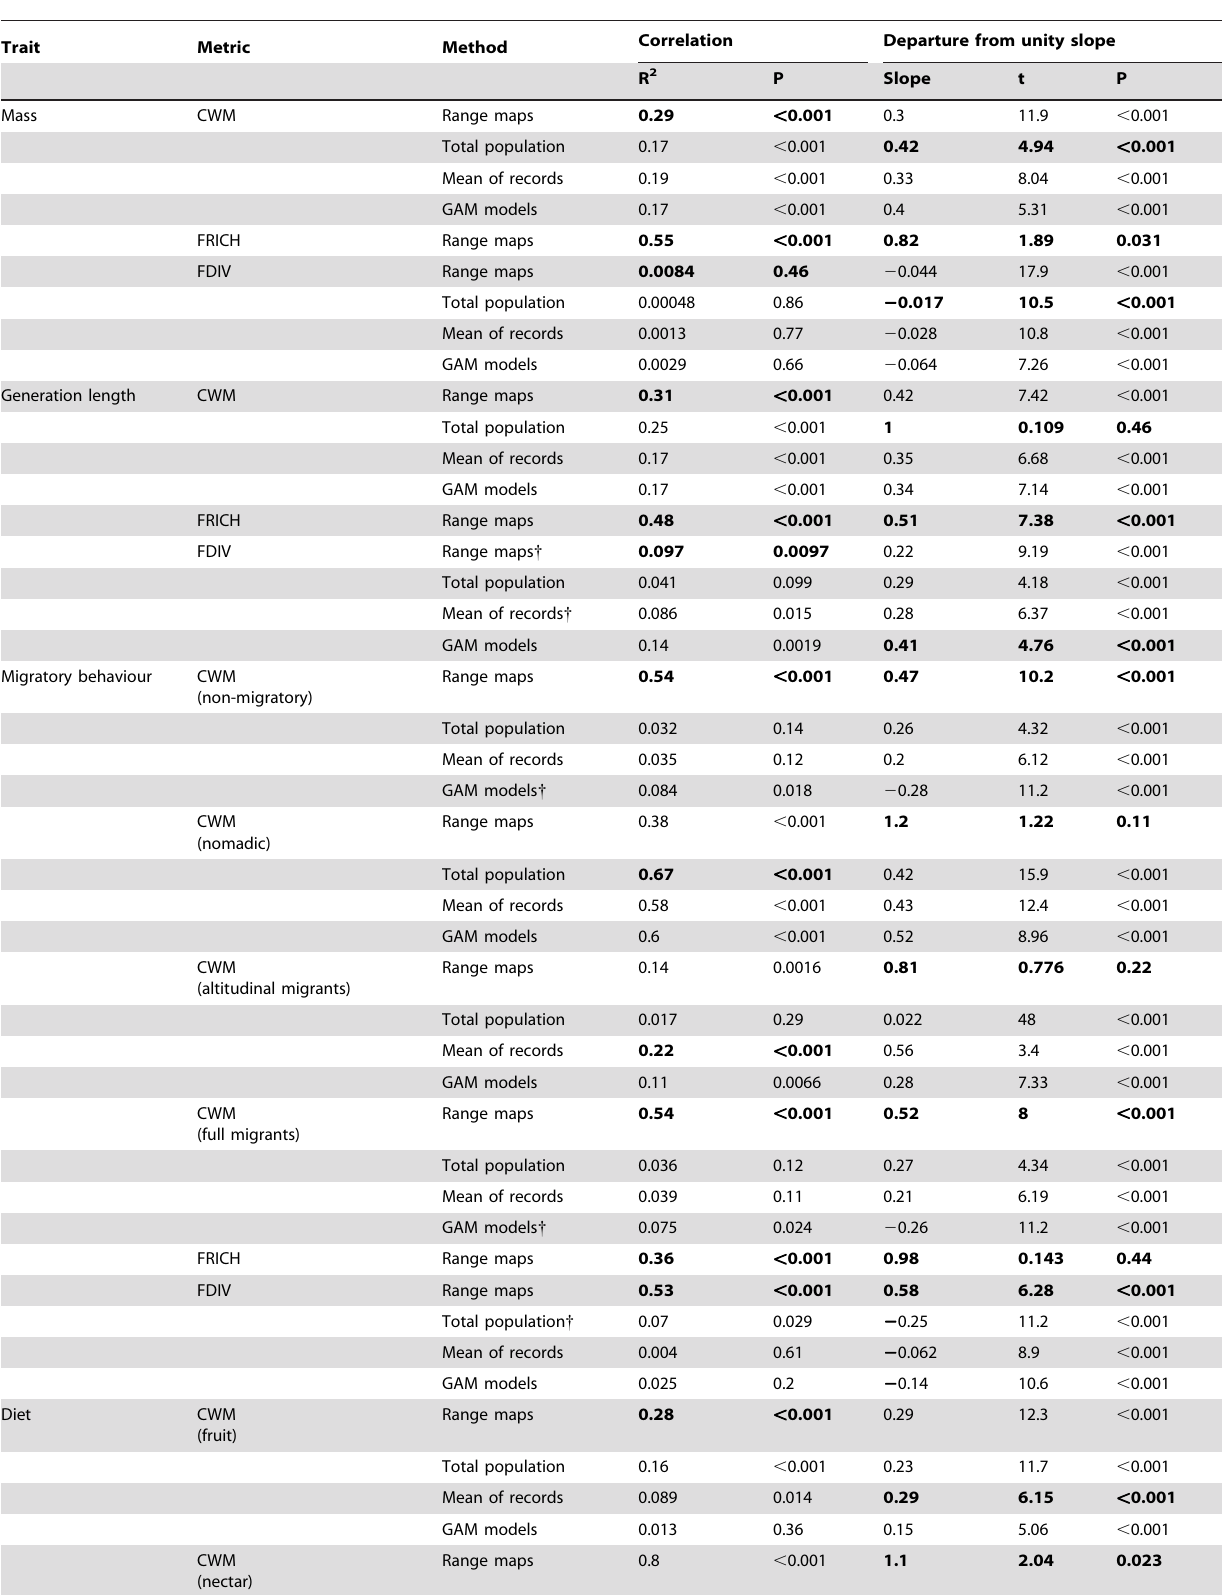
Table 1. Full results of the relationships between distribution-based and CBC-based estimates of community composition.